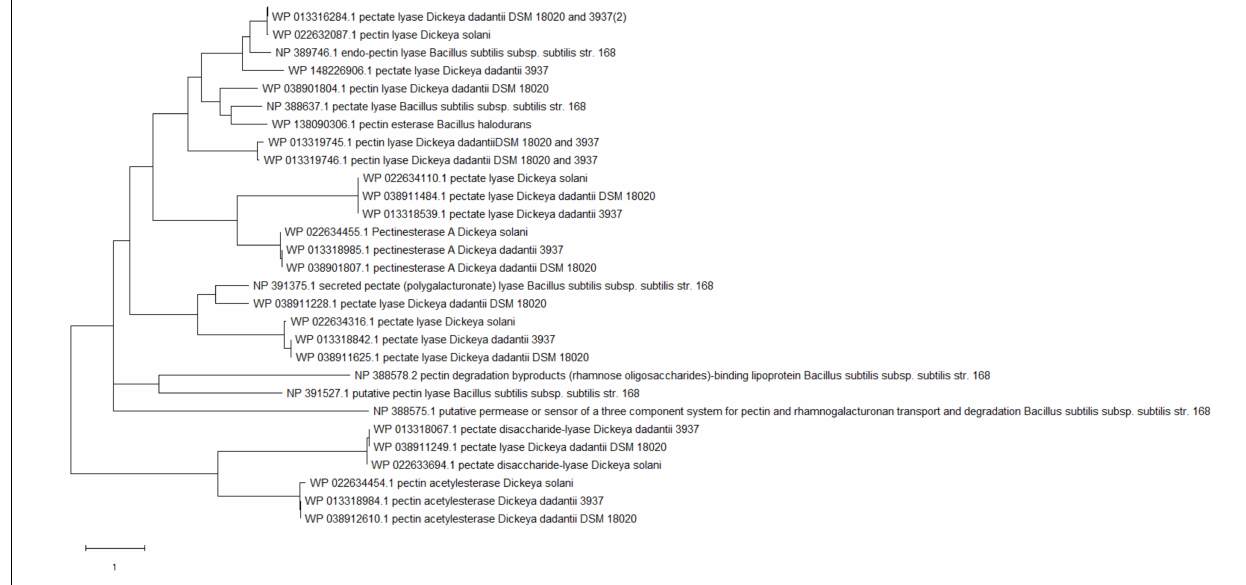
FIGURE 3 | Rooted phylogenic tree of pectin degrading enzymes encoded in the genomes of Dickeya dadantii 18020, D. dadantii 3937, D. solani IPO 2222, Bacillus subtilis subsp. subtilis str. 168, and B. halodurans C-125. Proteins encoded in the genome of the pectinase producers were aligned in MegaX using ClustalW where Maximum Likelihood was utilized to produce a Newick